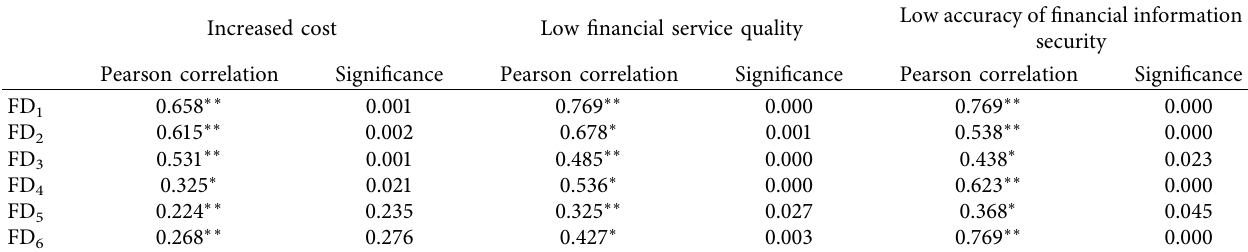
Table 1: Correlation analysis of frst-level evaluation indexes and diferent types of fnancial distress—Part 1. Increased